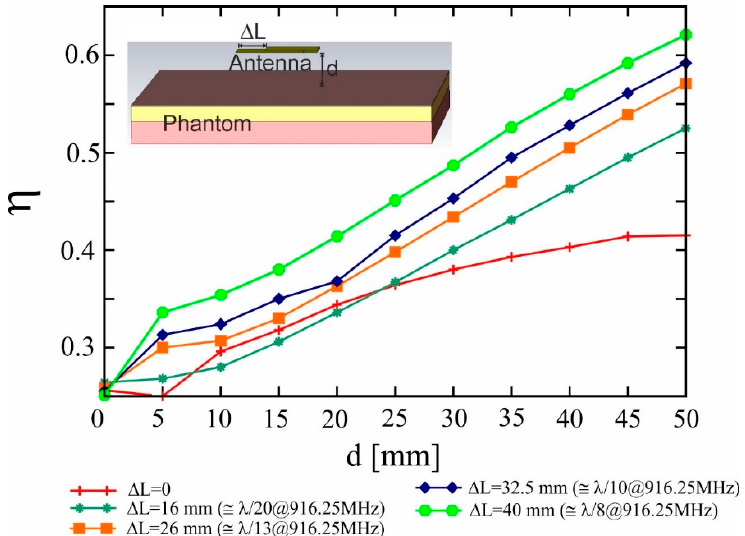
Figure 10. η with respect to the distance from the body phantom for different extensions of the antenna ground plane.